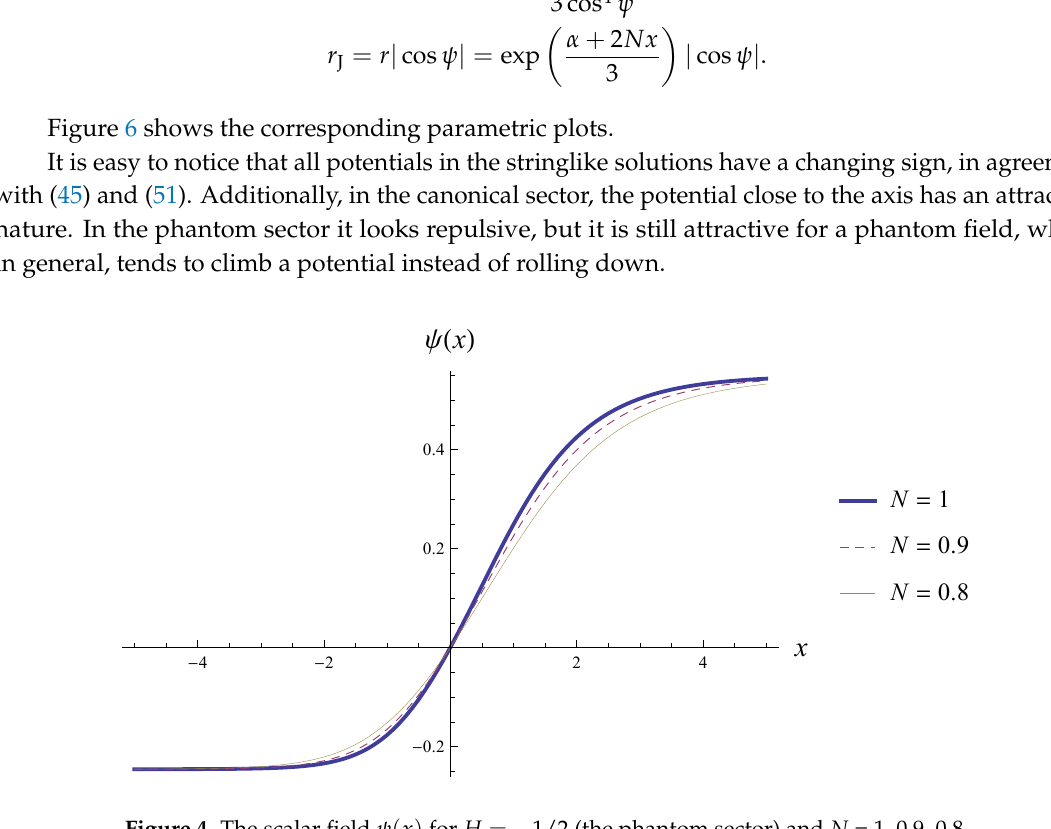
Figure 4. The scalar field ψ ( x ) for H = − 1/2 (the phantom sector) and N = 1, 0.9,